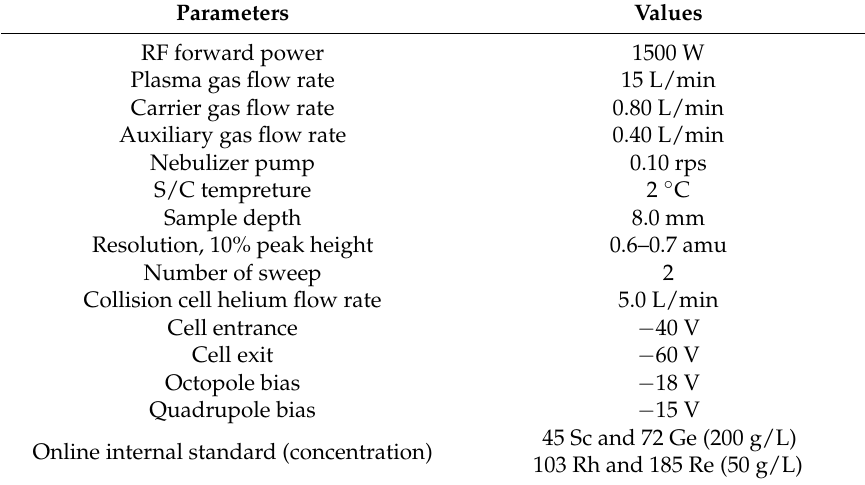
Table 1. Optimized instrumental parameters of inductively-coupled plasma mass